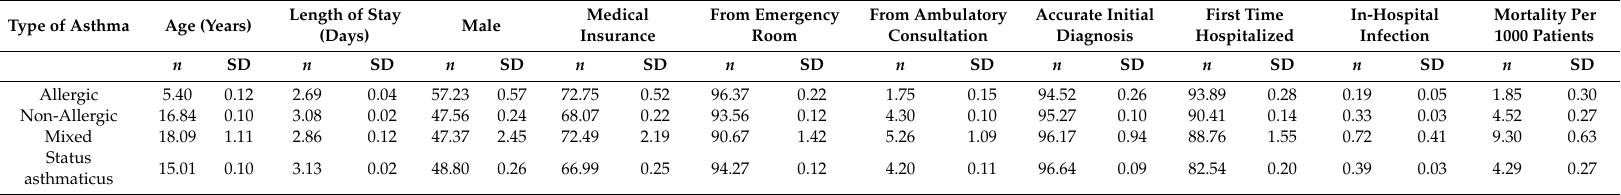
Table 3. Characteristics of patients hospitalized in Mexico with asthma as primary diagnosis in 87,726 cases occurred between 2010 and 2018 (showing means / percentages followed by standard